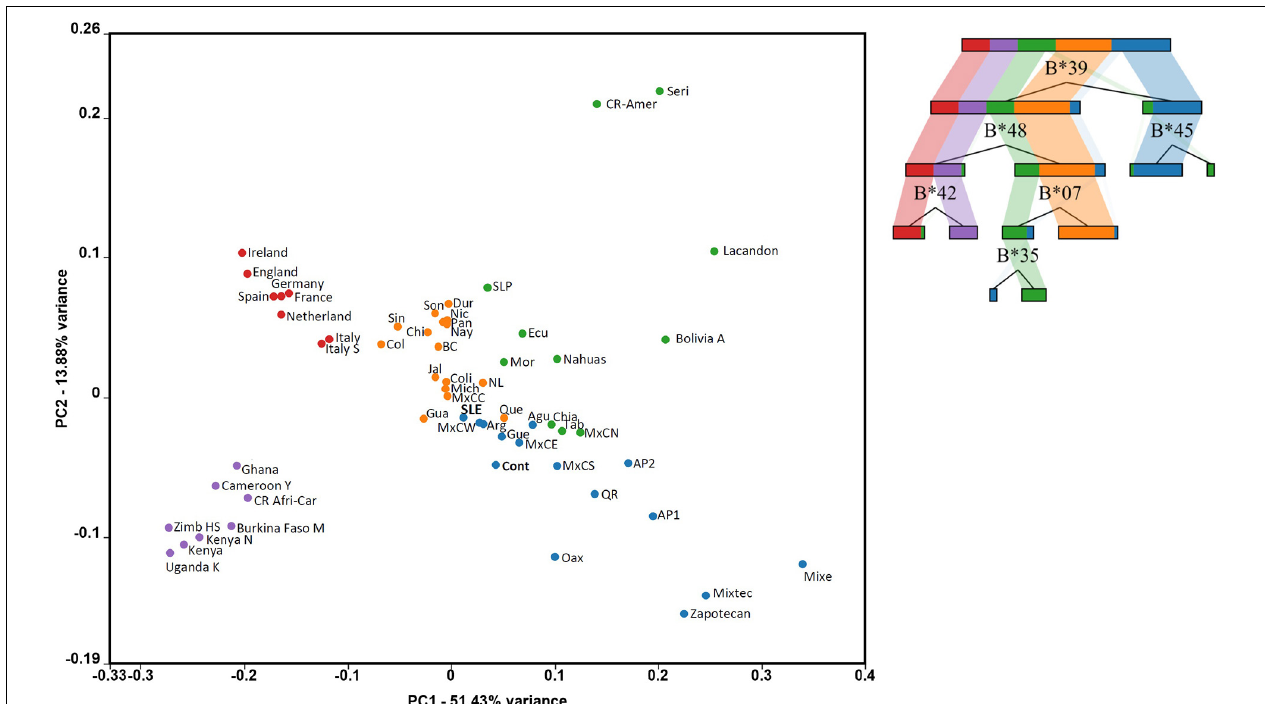
FIGURE 3 | The principal component analysis (PCA) plot shows the SLE Mexico City particularities. Populations are colored by high variance features represented by the alleles in the decision tree shown on the right. Some populations match in color and continental location with the HLA allele frequency discrimination. Purple dots represent African, and red represent European. Orange, blue, and green dots represent Mestizo and Native populations from Mexico states and Central and South America, properly described in the “Materials and Methods” section. Burkina Faso M: Burkina Faso Mossi, Uganda K: Uganda Kampala, Cameroon Y: Cameroon Yaounde, Kenya N: Kenya Nandi, Ghana: Ghana Ga-Adangbe, Italy S: Sardinia, BC: Baja California, Coli: Colima, Sin: Sinaloa, Dur: Durango, Son: Sonora, and NL: Nuevo León, Nic: Nicaragua, Pan: Panama, Col: Colombia, Que: Queretaro, Gua: Guanajuato, Mich: Michoacán, MxCC: Mexico City Center. Agu: Aguascalientes, Gua: Guanajuato, Que: Queretaro, Gue: Guerrero, Mich: Michoacán, SLP: San Luis Potosí, Nay: Nayarit, Jal: Jalisco, MxCC: Mexico City Center, MxCW: Mexico City Western, MxCE: Mexico City Eastern, MxCS: Mexico City Southern, MxCN: Mexico City Northern. Chi: Chiapas, Tab: Tabasco, Oax: Oaxaca, QR: